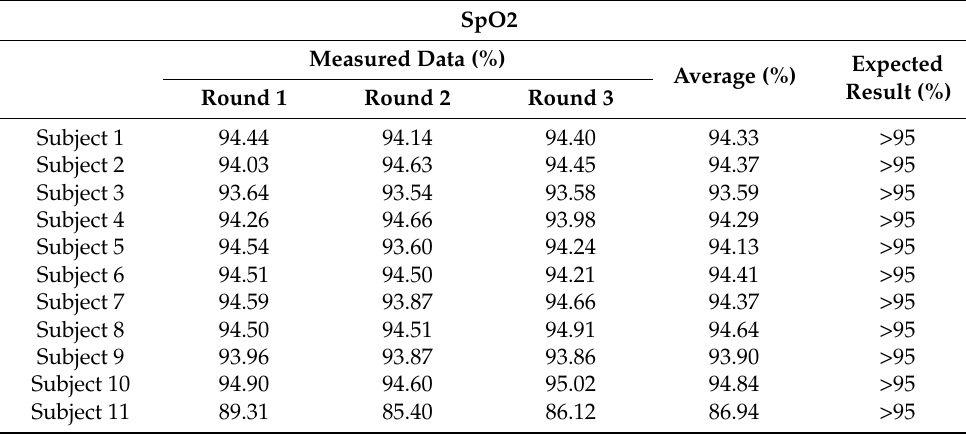
Table 7. SpO2 measured data and expected result.